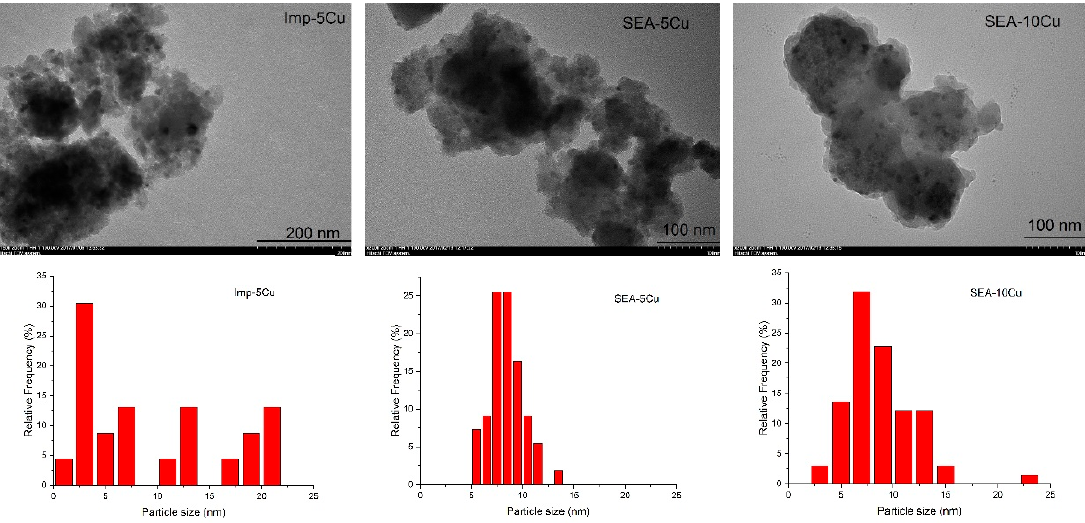
Figure 2. TEM images and particle size distribution of samples Imp-5Cu, SEA-5Cu, and SEA-10Cu.